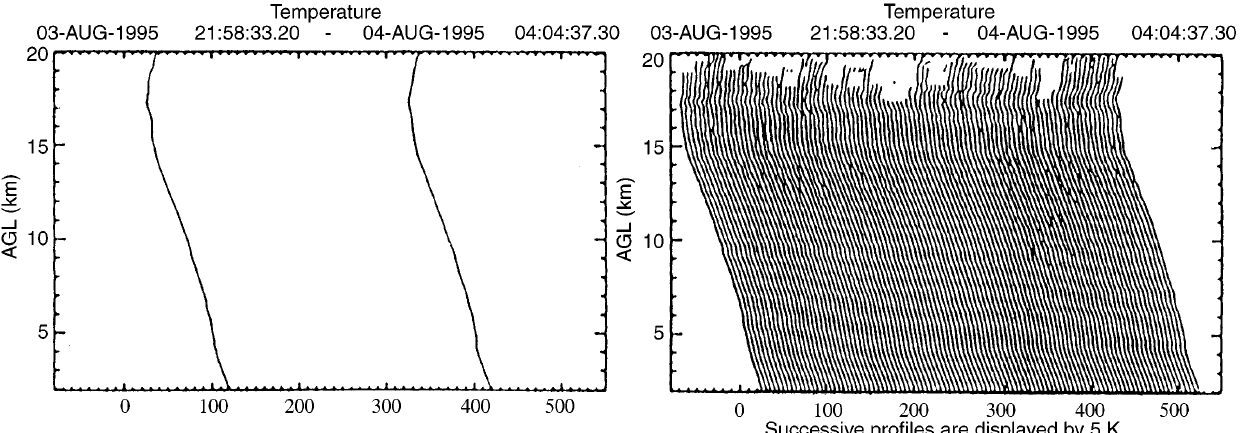
Fig. 12. ( Left ) temperature profiles obtained by radiosondes with an interval of six hours. ( Right ) temperature profiles obtained by the MU radar with RASS with an interval of 3.6 min (from Arikawa et al .,